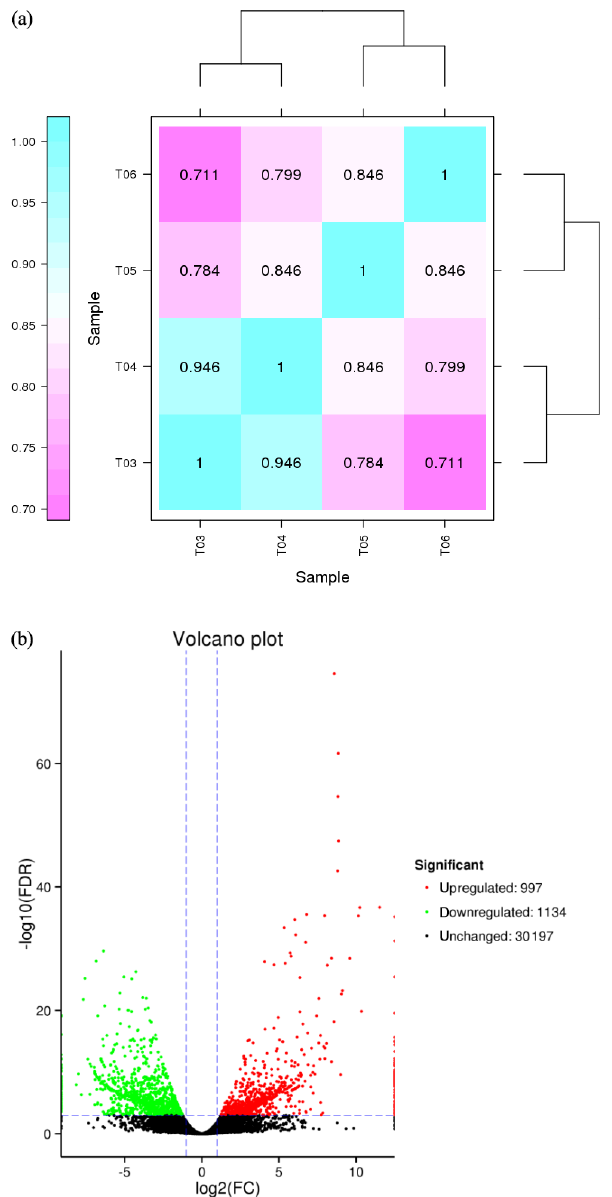
Figure 2. (a) Correlation heat map of gene expression level in four samples. Notes: T03 and T04 represent two biological replicates of Pekin ducks; T05 and T06 represent two biological replicates of mulard ducks. (b) Volcano plot of differentially expressed genes The abscissa is the value of log2 (FPKM), ie, the logarithm of the mean value of expression in both samples; the ordinate is the value of log2 (FC), the logarithm of the difference in gene expression be- tween two samples which used to measure differences in expres- sion. Each dot represents a gene. Green dot: genes with significantly downregulated expression; red dot: genes with significantly upreg- ulated expression; black dot: genes without differential expression. The expression level of the upregulated gene in mulard ducks is higher than that in Pekin ducks; the opposite is the case for the downregulated gene.